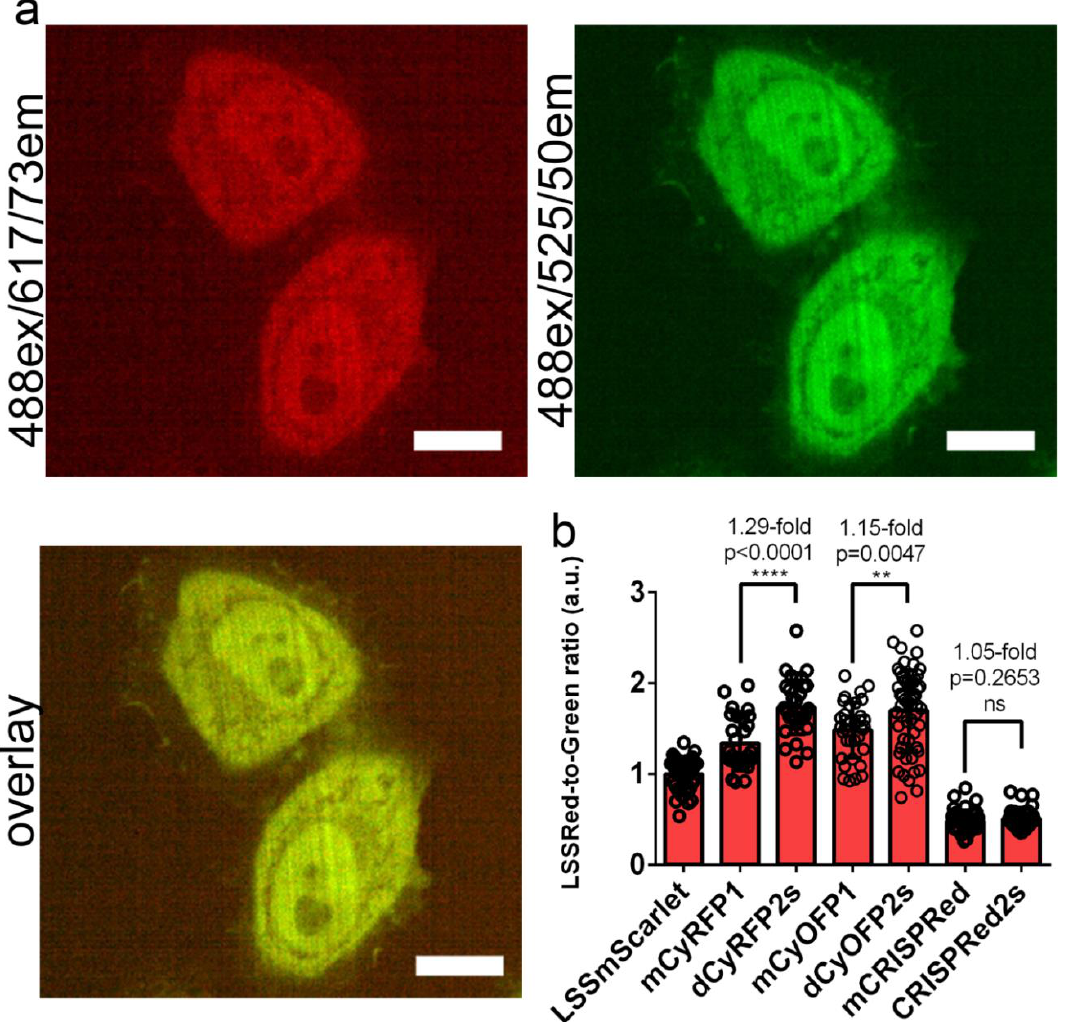
Figure 3. Comparison of the brightness of the LSSRFPs proteins in HeLa cells. ( a ) Confocal images of HeLa cells expressing the LSSmScarlet-P2A-EGFP protein (please, see Figure S3 for localization images for other LSSRFPs). LSSRed (488ex and 617/73em) and green (488ex and 525/50em) fluorescence channels and their overlay are shown. Scale bar, 100 µ m. ( b ) The averaged brightness for the LSSRFPs proteins in HeLa cells normalized to the brightness of the EGFP protein expressing in the same cells. The EGFP protein is connected to LSSRFPs via P2A-self cleavable linker. Error bars are standard deviations across twenty-eight–fifty-eight cells. p values show statistical difference between the respective values. Ns, not significant, p value is >0.05. ****, p value is <0.0001. **, p value is <